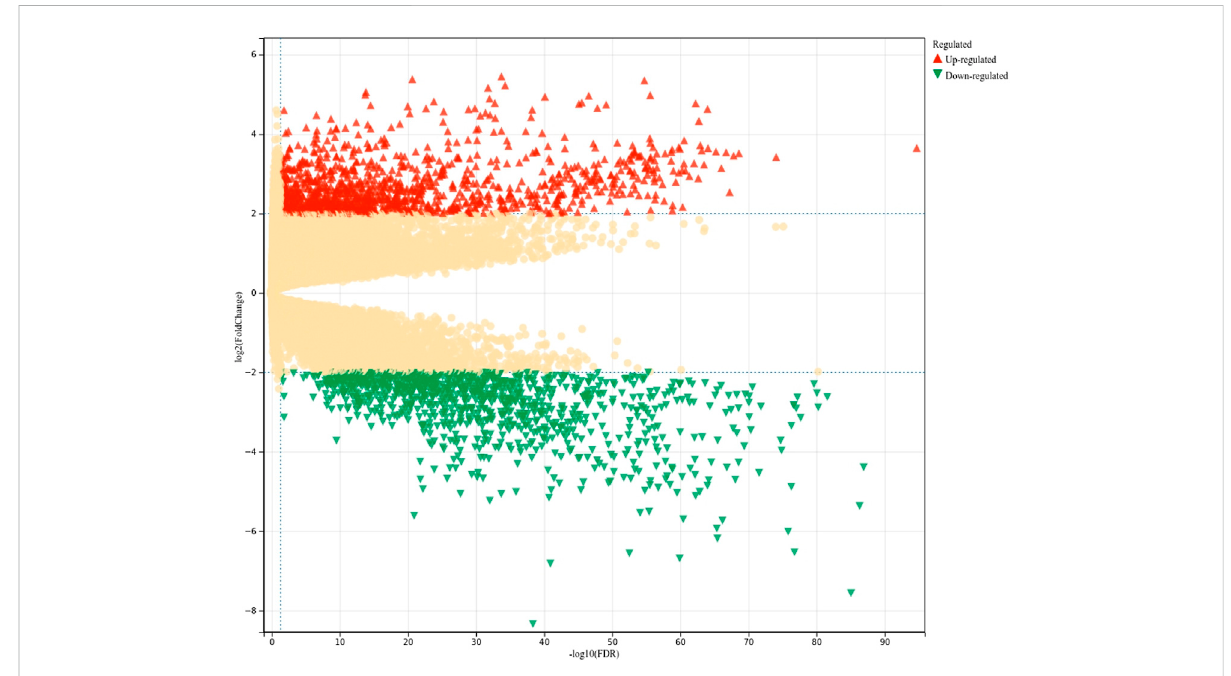
FIGURE 2 Analysis of differentially expressed LUAD-related genes. FDR, false discovery rate.